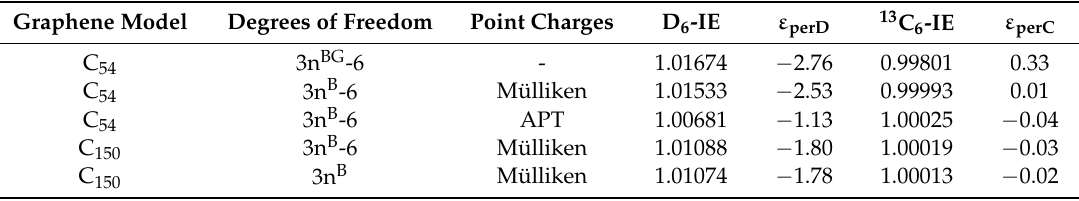
Table 4. The isotope effects (IE) and isotopic fractionations ( ε ) obtained using partial Hessian analysis at the ω B97xd/def2-TZVPP level of